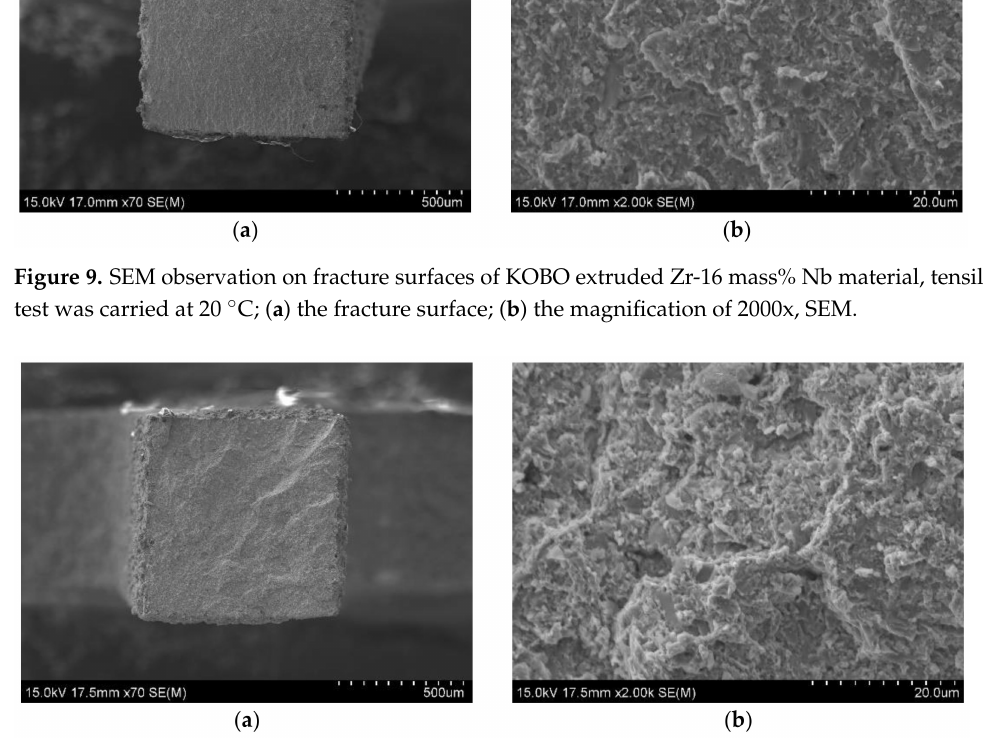
Figure 10. SEM observation on fracture surfaces of the KOBO extruded Zr-16 mass% Nb material, tensile test was carried at 400 ◦ C; ( a ) the facture surface; ( b ) the magnification of 2000x, SEM. The tensile test curve at 400 ◦ C for the SPS sintered zirconium without additives